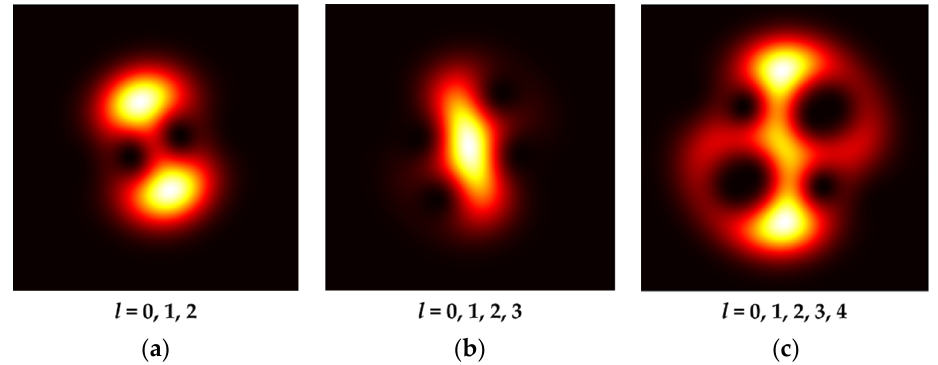
Figure 1. Optical intensity profile of multimode LG beams. ( a ) l = 0, 1, 2; ( b ) l = 0, 1, 2, 3; ( c ) l = 0, 1, 2, 3, 4.